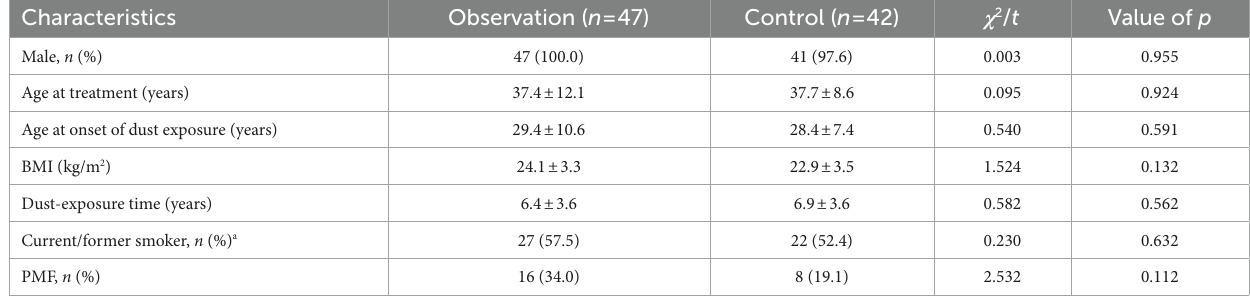
TABLE 1 Demographic characteristics of the observation and control